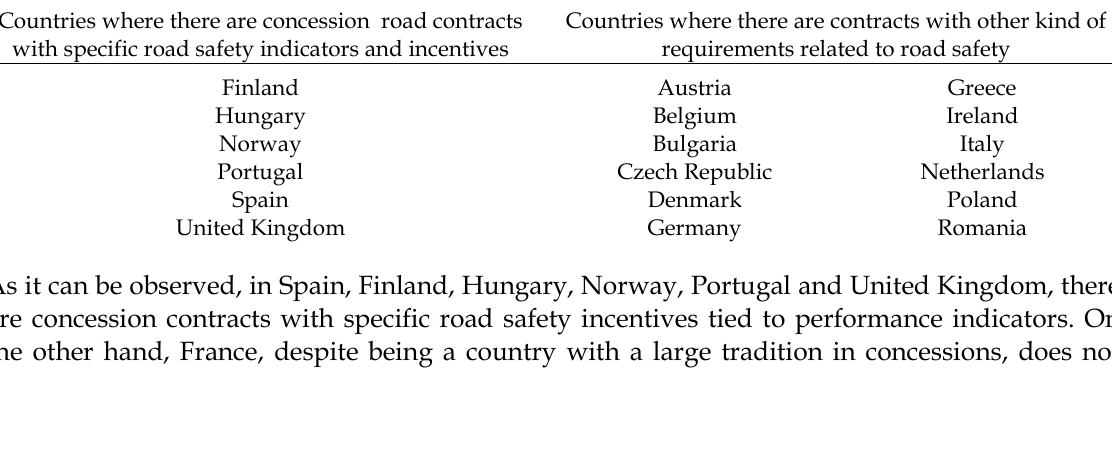
Table 1. Breakdown of the introduction of Road Safety